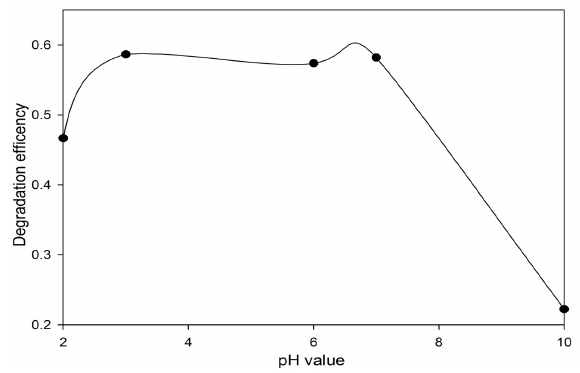
Figure 2: The effect of pH on the degradation of 50 mg/L methylene blue using 0.5 mM PMS at 24 h.